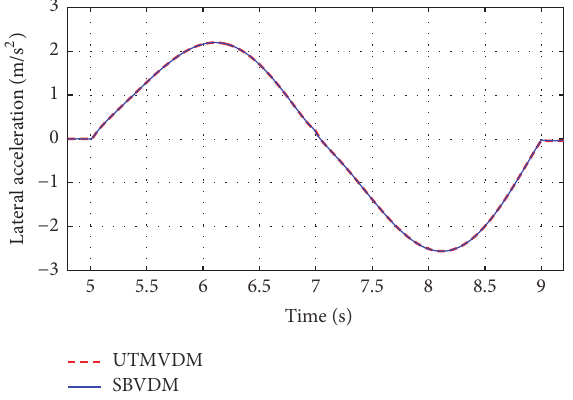
Figure 15: Lateral acceleration for sinusoidal steering test.